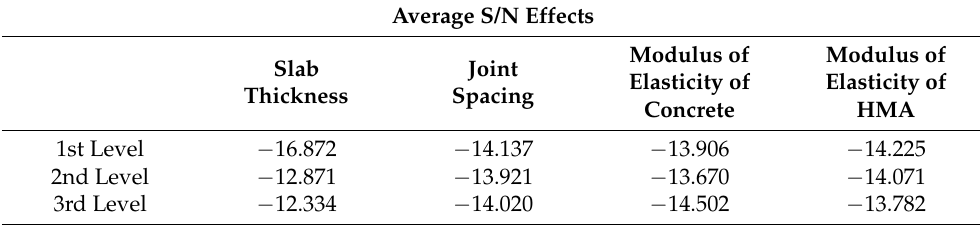
Table 10. S/N effects table.